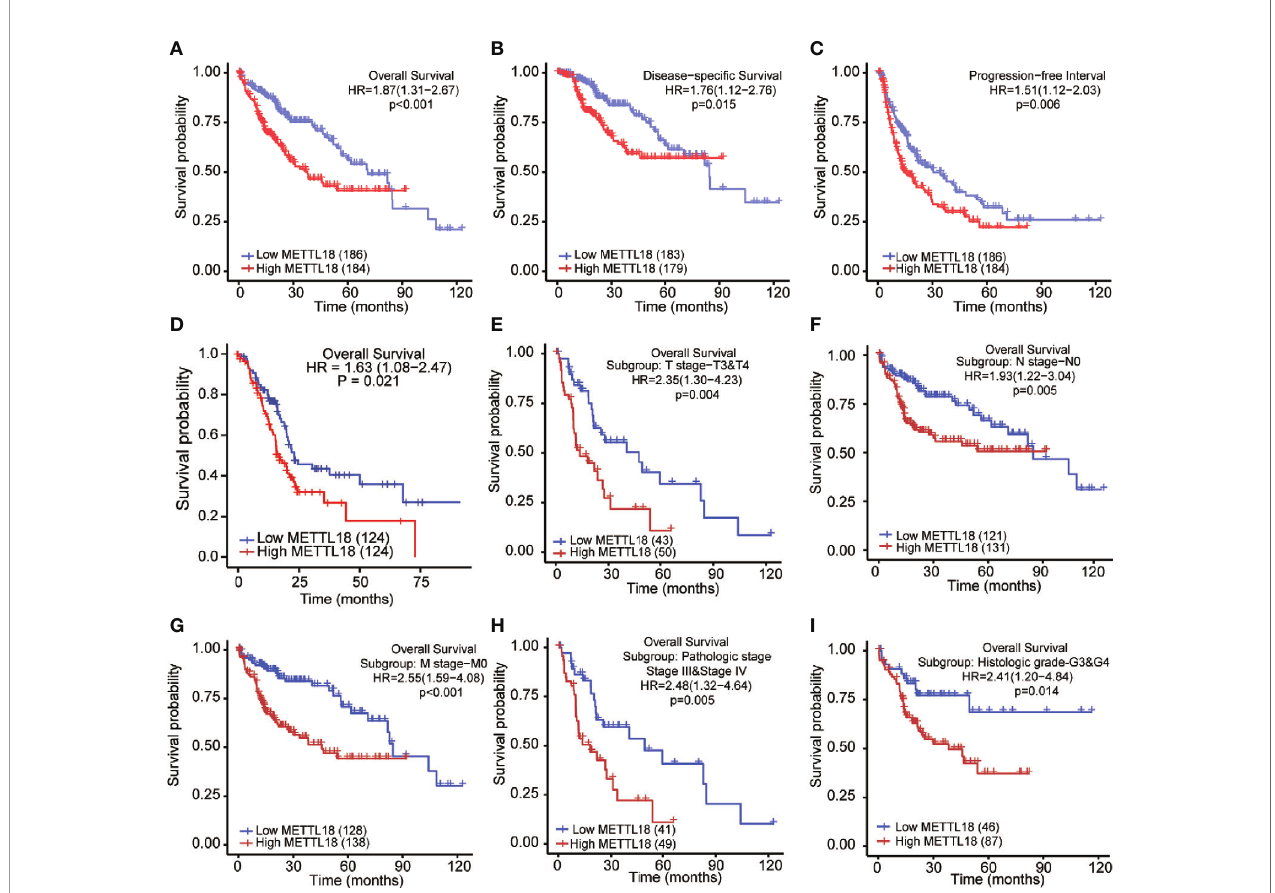
FIGURE 5 | Kaplan – Meier survival plots comparing the low and high expression of METTL18 in HCC. (A – D) Survival curves of OS, DSS, and PFI between high and low expression of METTL18 in patients with HCC. (E – I) OS survival curves of T stages 3 and 4, N0, M0, pathologic stages III and IV, and G3 and 4 subgroups between METTL18-high and -low patients with HCC. HCC, hepatocellular carcinoma; OS, overall survival; DSS, disease speci fi c survival; PFI, progression free interval.